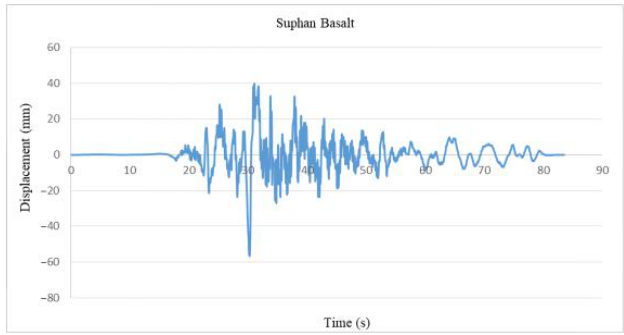
Figure 19. Time-displacement curve for minaret made of Süphan basalt.